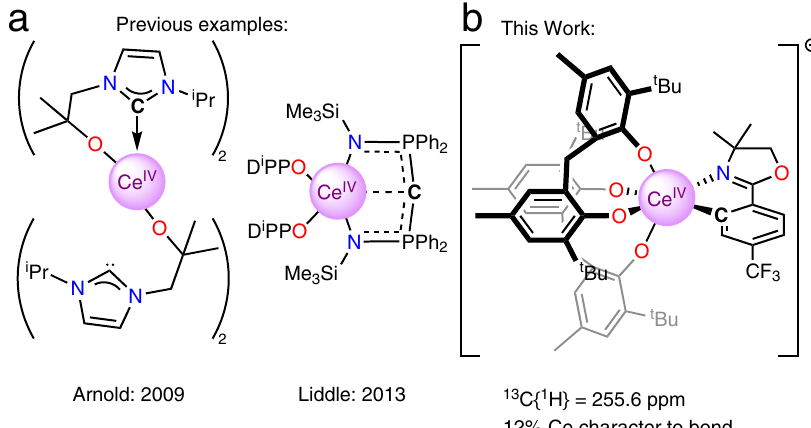
Fig. 1 Examples of Ce IV − C σ bonds. a Previous examples of complexes with formally Ce IV − C σ bonds, which are stabilized by either nitrogen 22 or phosphorus heteroatoms 23 . b This work detailing the synthesis and characterization of a Ce IV − C aryl bond, including computational analysis. Carbon atoms bound to cerium are indicated with a C